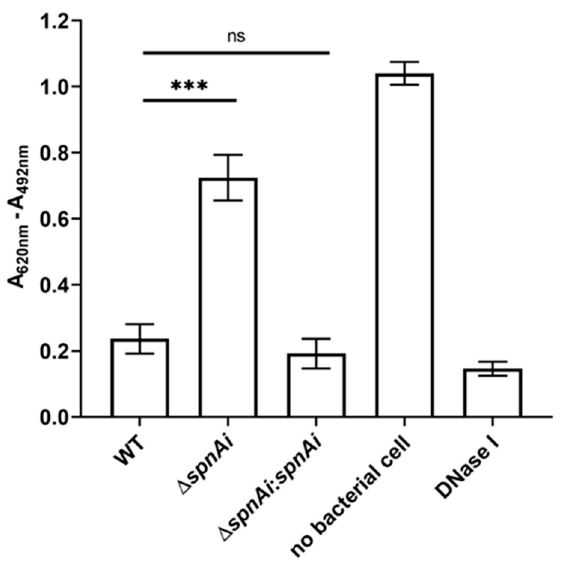
Figure 1. DNase activity of Streptococcus iniae strains. The DNase activity against salmon sperm DNA was determined for wild-type (WT) S. inia , S. iniae ∆ spnAi and S. iniae ∆ spnAi : spnAi using a methyl green assay [43]. A decrease in the reading of A 620nm - A 492nm indicates DNA digestion. The error bars show the standard deviation of three experiments performed in triplicate. ***, p < 0.001; ns, not significant (as determined by an unpaired two-tailed t -test).